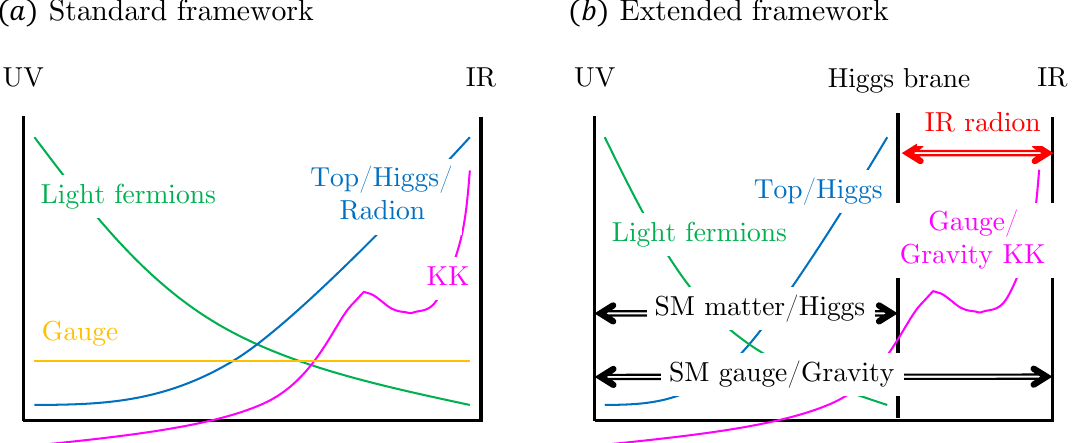
Figure 1 . Left: Warped extra-dimensional model with SM fields in the same bulk (standard framework). Schematic shapes of extra-dimensional wavefunctions for various particles (zero mode SM fermions and gauge particles, a radion, and a generic KK mode) are shown. Right: Warped extra-dimensional model with all SM gauge fields and gravity in the full bulk, but matter and Higgs fields in subspace (extended framework). Schematic shapes of extra-dimensional wavefunctions for various particles (zero mode SM fermions and gauge bosons, an IR radion, and gauge/gravity KK modes) are shown. The double-lined arrows indicate that the associated fields propagate within the marked range in the extra